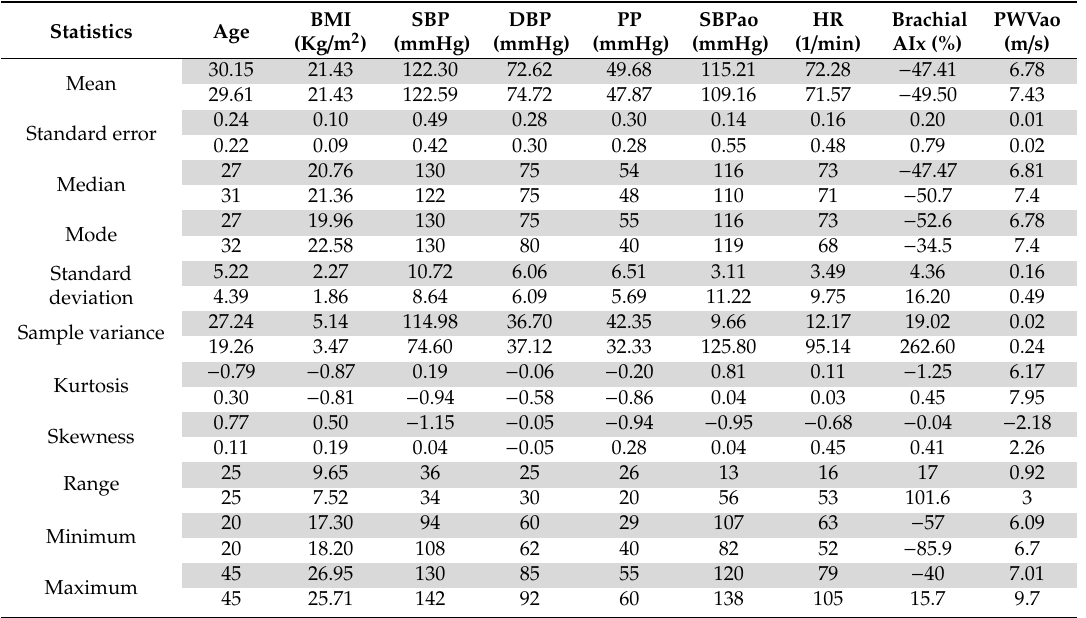
Table 2. Anthropometric, haemodynamic and arterial sti ff ness characteristics of both groups (group 1, N1 = 471—healthy pregnant patients; group 2, N2 = 416—control